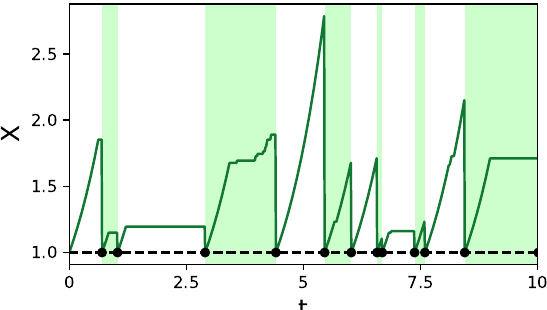
Figure 12. A typical trajectory of particles in the presence of stochastic resetting to the initial position ( x ) = ( 1,0 ) for r = 1, D = 1, and v = 1. The resetting events are represented by black dots. 0 , y 0 Dashed regions are introduced for these resetting events to be more